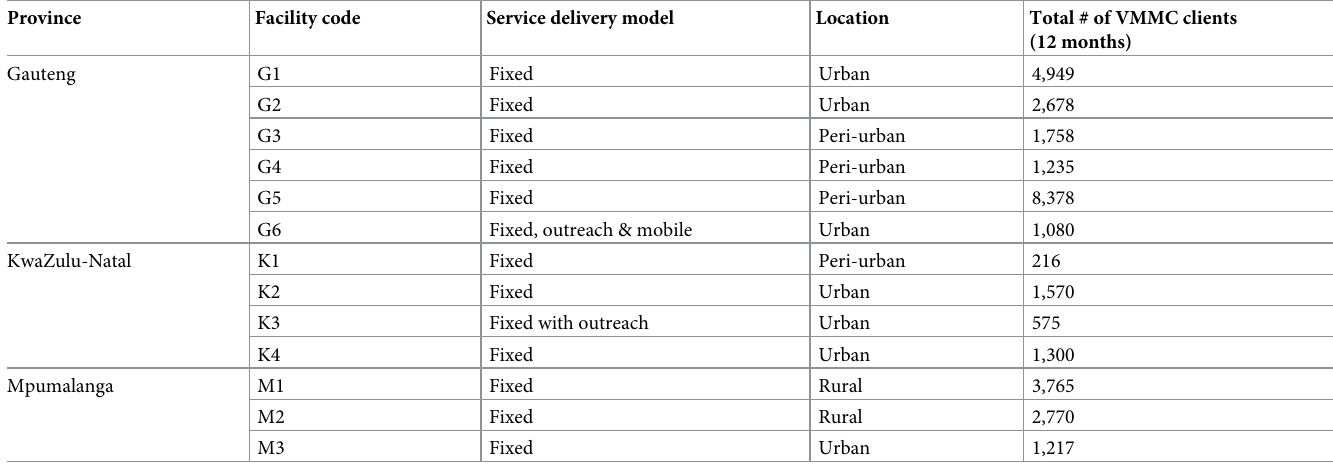
Table 1. VMMC facilities